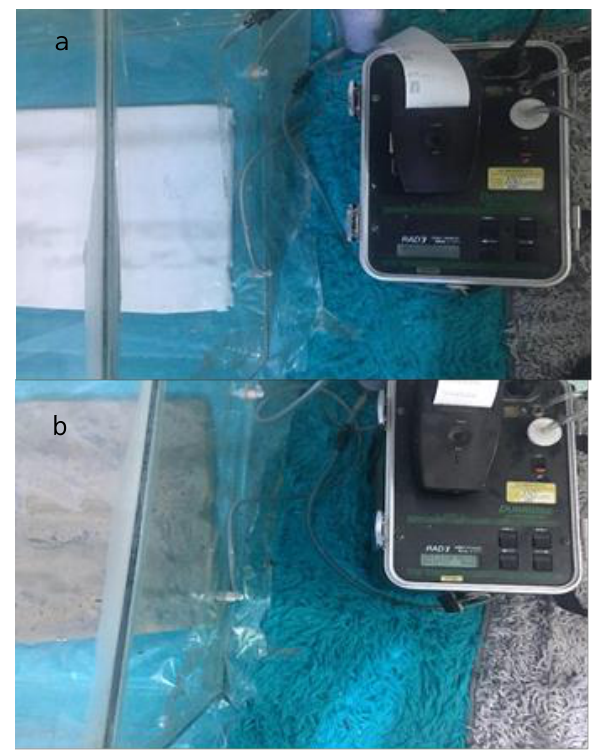
Figure 2: (a) Measurement setup of RAD7 detector (first stage). (b) Measurement setup of RAD7 detector (second